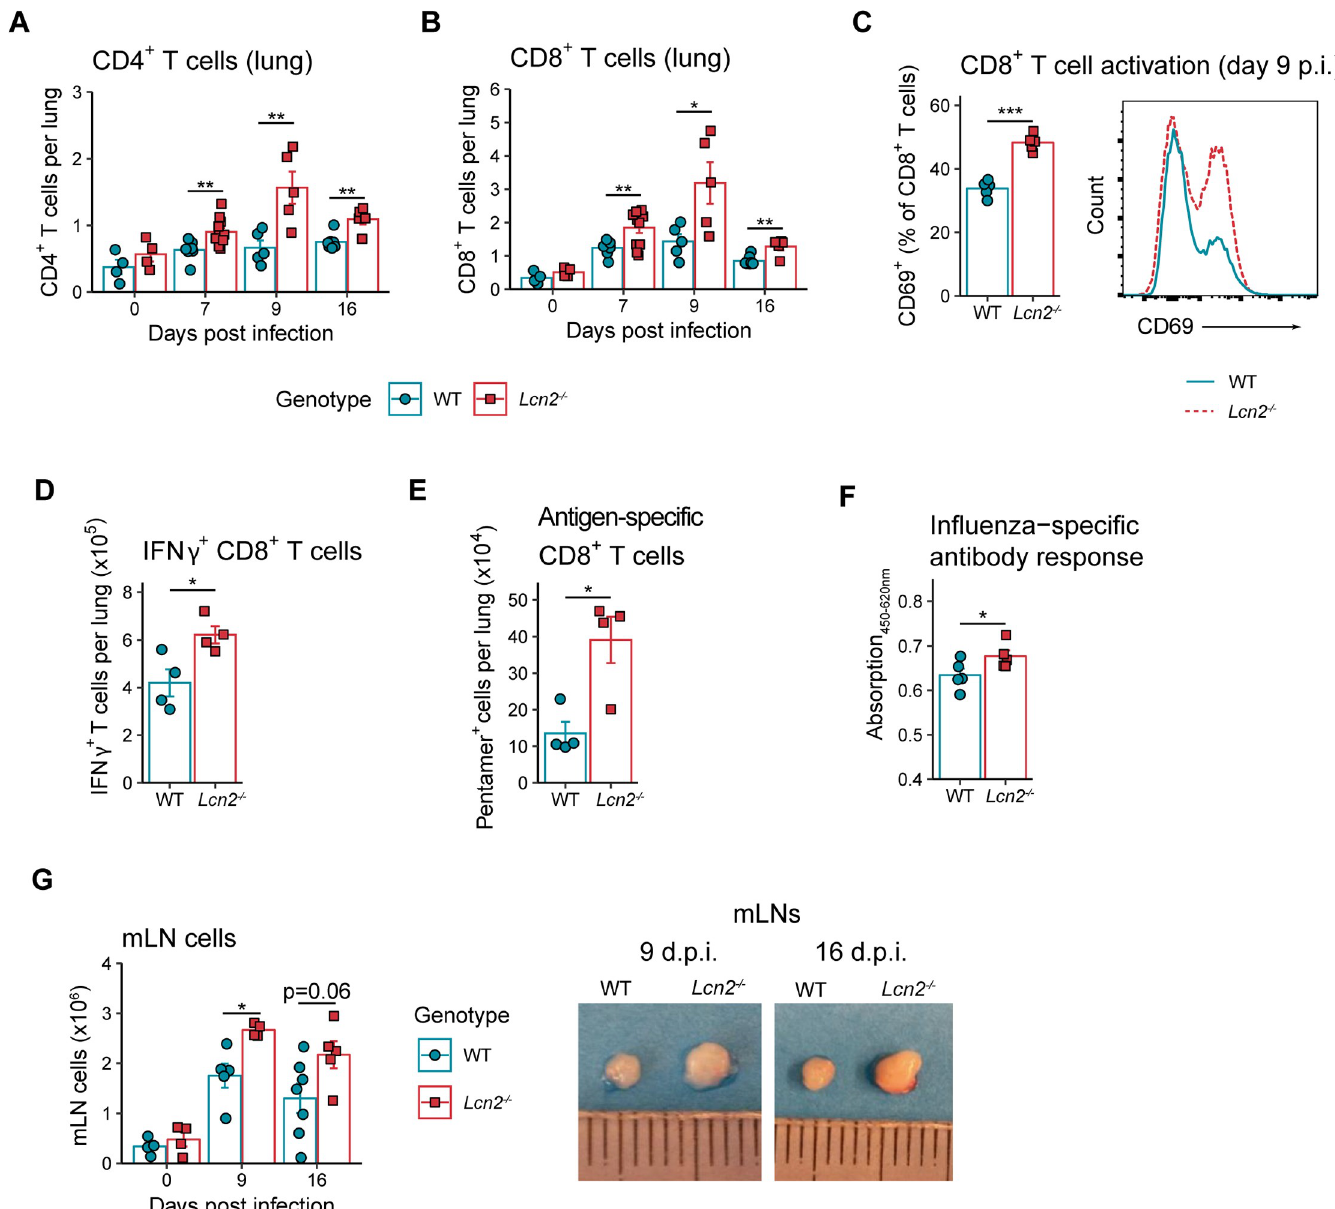
Fig 2. LCN2 reduces lung T cell numbers and mediastinal lymph node size during influenza infection. (A, B) CD4 + (A) and CD8 + T cell counts (B) in lungs of WT and Lcn2 -/- mice at baseline (d0) or at indicated timepoints after infection with 10 PFU PR/8. n = 4 (baseline), 7–10 (day 7), 5 (day 9) and 5–7 (day 16 post infection) per genotype. Data are representative of two independent experiments. (C) Percent of activated (CD69 + ) CD8 + lung T cells 9 days post infection. Quantification and representative histograms of are shown. n = 5 per genotype. (D) Number of IFN γ + lung CD8 + T cells. n = 4 per genotype . (E) Number of antigen-specific (PR8 pentamer + ) lung CD8 + T cells. n = 4 per genotype . (F) Total influenza-specific IgG levels in serum collected from mice 16 days after influenza infection. n = 5 per genotype. (G) Mediastinal lymph node (mLN) leukocyte counts and representative images of mLNs 9 and 16 days after influenza infection. n = 4 (baseline), 4–5 (day 9 post infection) and 5–7 (day 16 post infection) per genotype. Bar diagrams show group means +/- SEM. Statistical significance for comparisons between genotypes for was assessed using Student’s t test. � p < 0.05, �� p < 0.01, ��� p < 0.001.